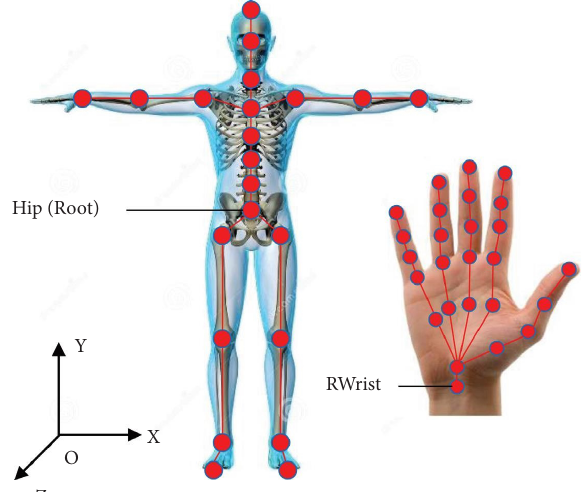
Figure 2: Schematic diagram of the appearance of the human skeleton model.